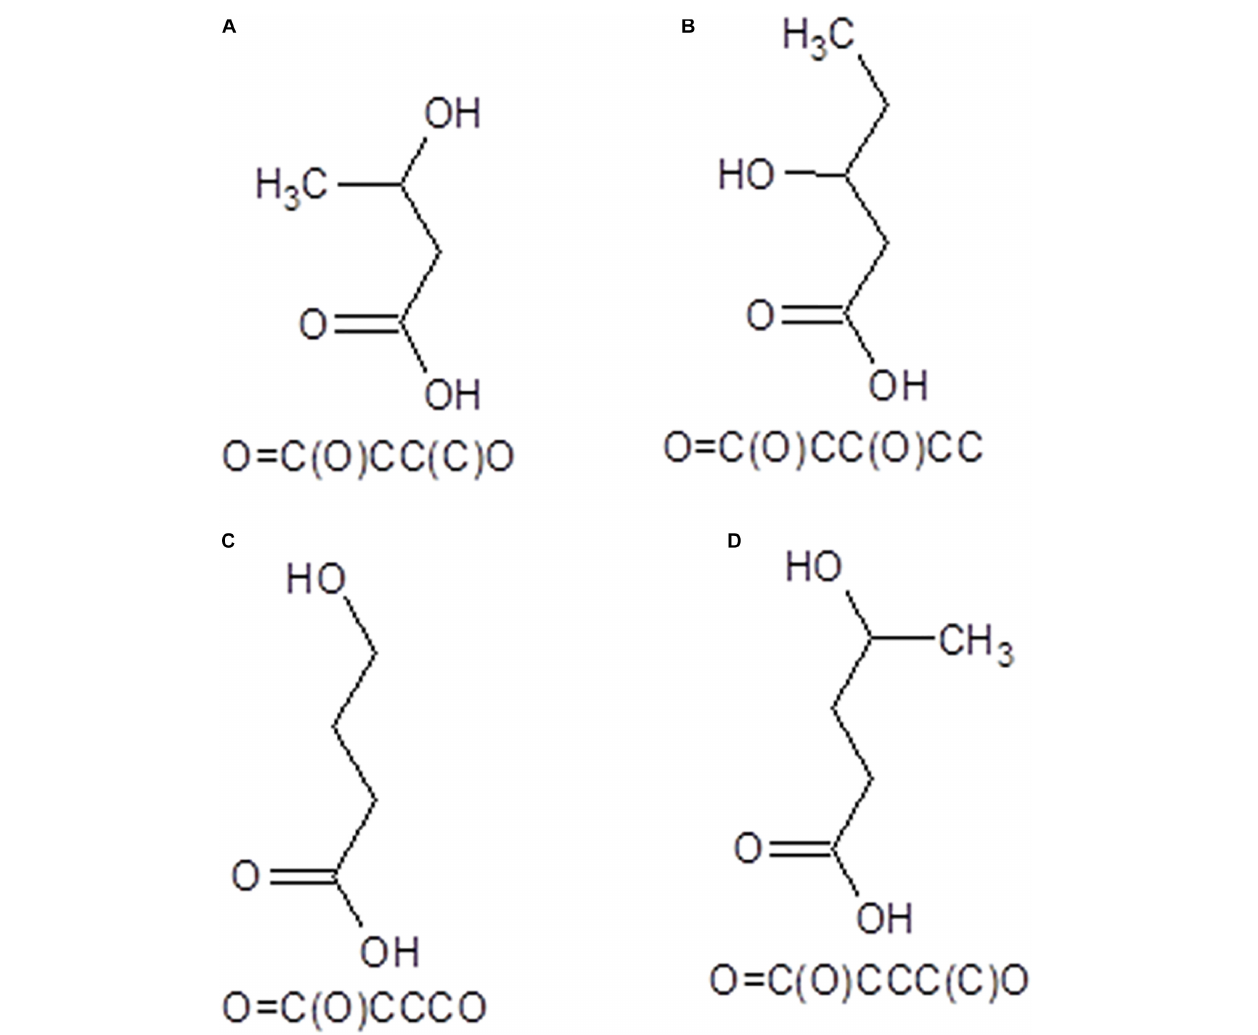
FIGURE 1 | SMILES and 2D structural formulas of the monomeric units of O3HB (A) , O3HV (B) , O4HB (C) , and O4HV (D) oligomers that have been investigated in this study.